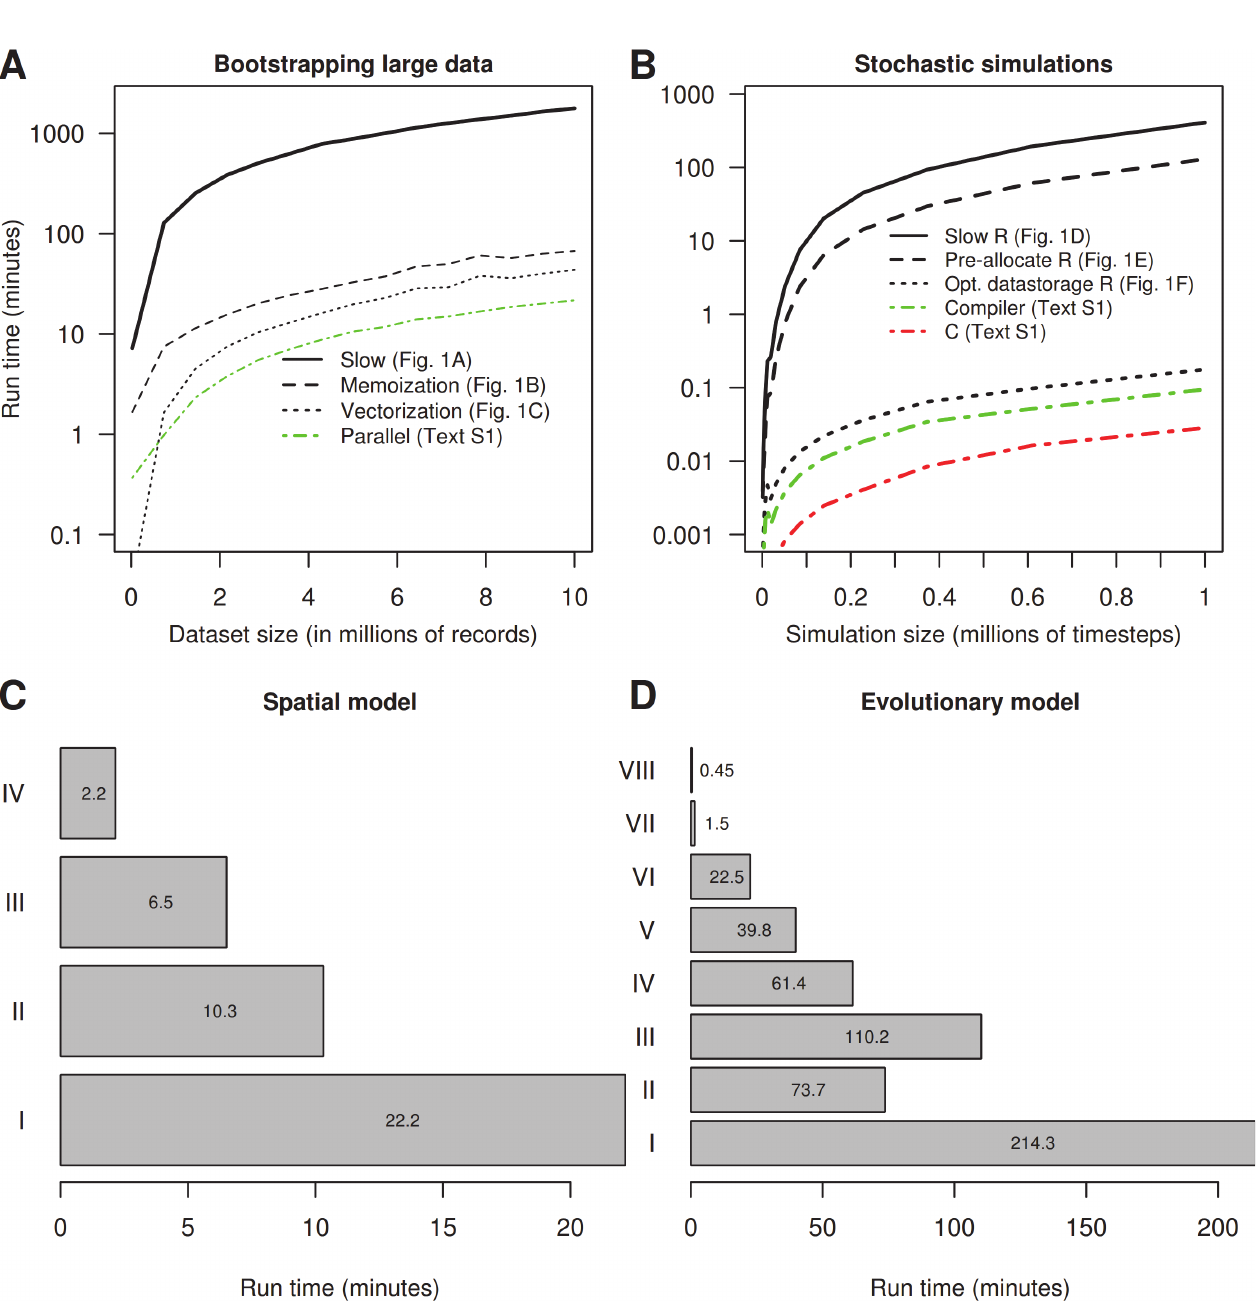
Fig 2. Execution time in minutes, required to complete various computational problems, using the optimization techniques discussed. Panels A and B show the execution time as a function of problem size for 10,000 bootstrap resamples conducted on datasets varying in size (A) and time required to run a stochastic population model against the number of time steps (B). "Naive" R code, in which no optimizations are applied, uses most computing resources (solid lines in A and B). Optimized R code, with use of efficient functions and optimal data structures pre-allocated in memory (dashed lines in A and B), is faster. In both panels A and B, the largest speed-ups are obtained by using optimal R code (black lines). Subsequent use of parallelism causes further improvement (dot-dashed green line) in A. In panel B, using R's byte compiler improved execution time further above optimal R code (dotted lines in green) while the smallest execution times were achieved by refactoring code in C (red dot-dashed lines). Panels C and D give the computing time (in minutes) needed to conduct the calculations from (C) Merow et al. [10] and (D) the calculations represented by Fig. 3 in Visser et al. [11]. Bars in panel C represent the original unaltered code from [10] (I), the unaltered code run in parallel (II), the revised R code where we replaced a single data.frame with a matrix (III) and the revised code run in parallel (IV). Bars in panel (D) represent the original unaltered code [11] (I), original run in parallel (II), optimized R code (III), optimized R code using R's byte compiler (IV), optimized R code run in parallel (V), optimized R code using byte compiler run parallel (VI), code with key components refactored in C (VII), and parallel execution of refactored code (VIII). All parallel computations were run on 4 cores, and code is provided in S1 Text, section 3, S2 and S3